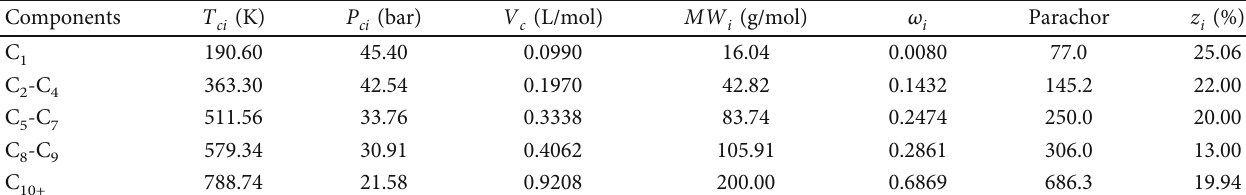
Table 3: The composition and physical property parameters of crude oil for the Bakken formation. Components